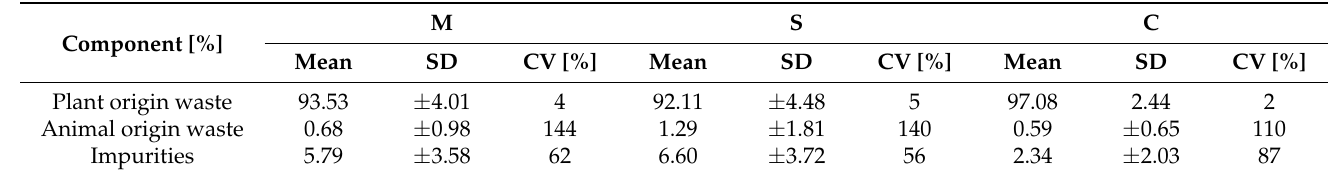
Table 2. Average composition of SS-OFMSW from different sources (M, S, C).